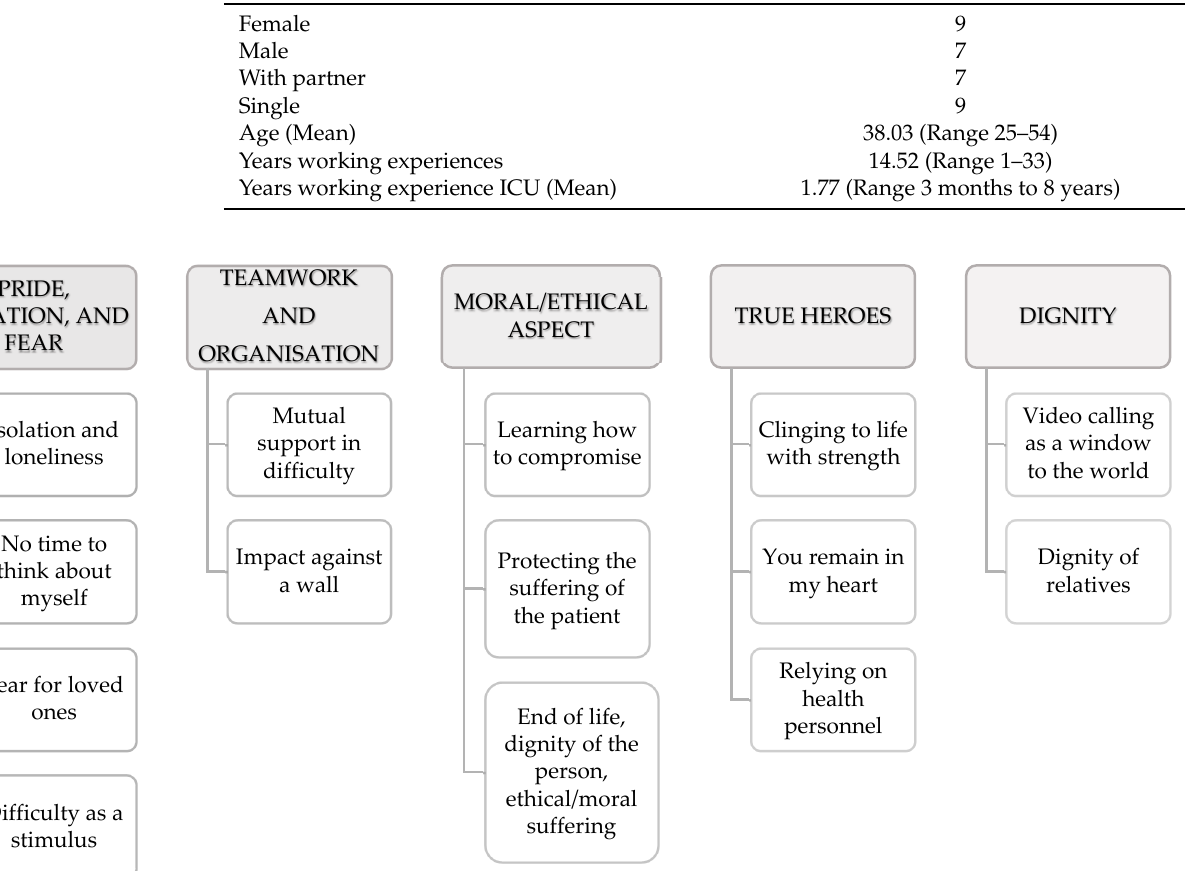
Figure 1. Themes and subthemes identified.